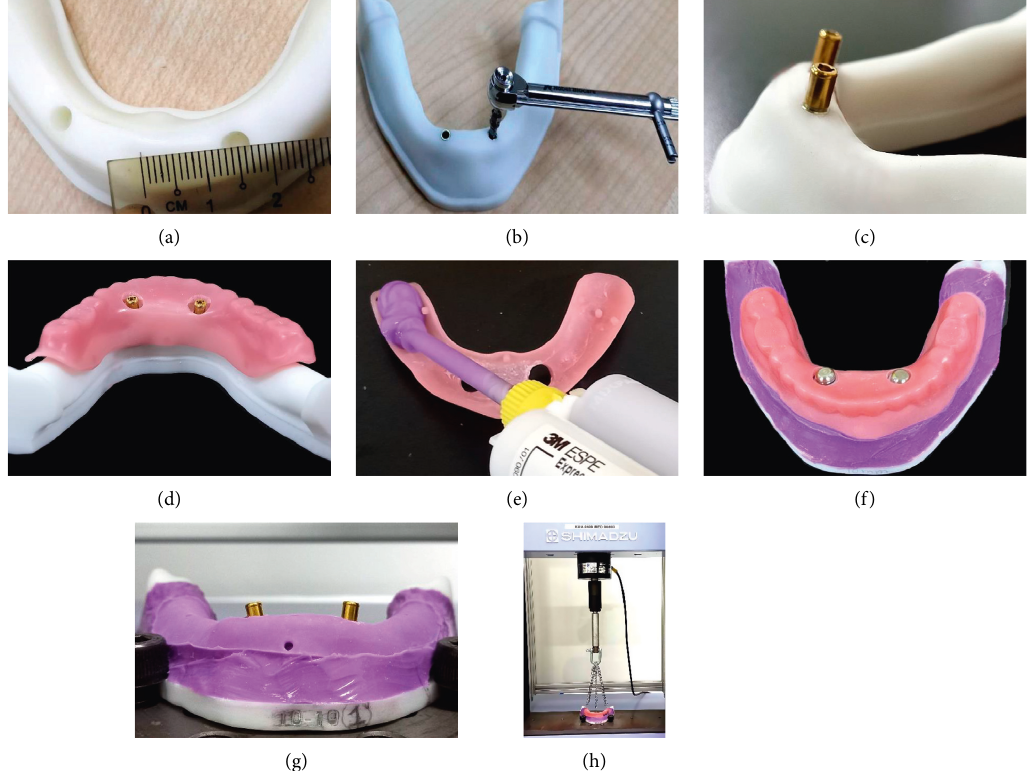
Figure 2: Methodology of 2IMO simulation using 3D-printed models. (a) Representative 3D mandibular model of the 15mm group. (b) Implant placement in predetermined holes. (c) LOCATOR male attachment placed onto implants. (d) Holes created in denture corre- sponding to area of attachments. (e) Soft-tissue layer simulated using VPS material. (f) Denture ready to pick up female attachment using autopolymerizing acrylic resin. (g) The mandibular 3D model with 10-10 degree angulation attached to a universal testing machine. (h) Vertical pull force applied to